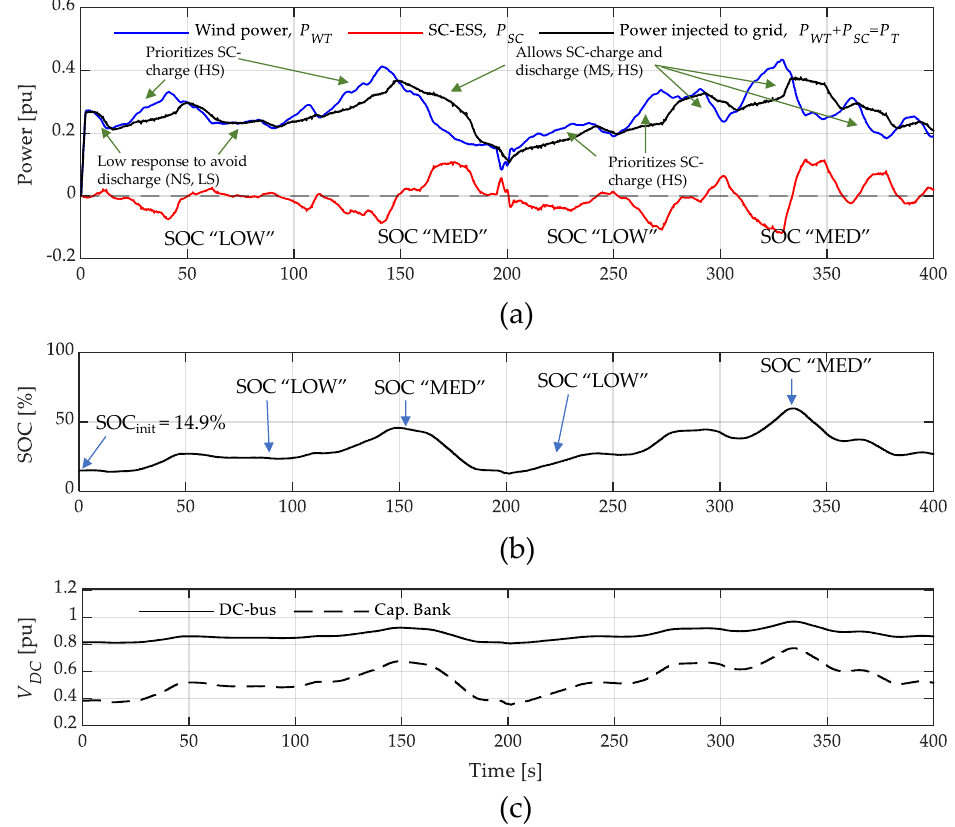
Figure 19. Experimental results in SC–ESS undercharge condition: ( a ) original injected wind power (blue), power delivered by SC–ESS (red), combined wind-supercapacitors effect with the smoothing algorithm (black); ( b ) evolution of SOC; ( c ) DC voltage of the supercapacitor array upstream of the inverter.